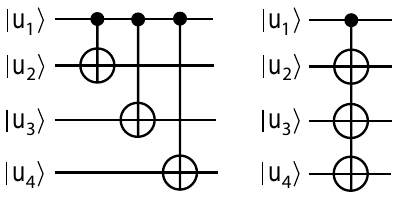
Figure 5: A multi-target, single control circuit (left) can be compacted into the circuit on the